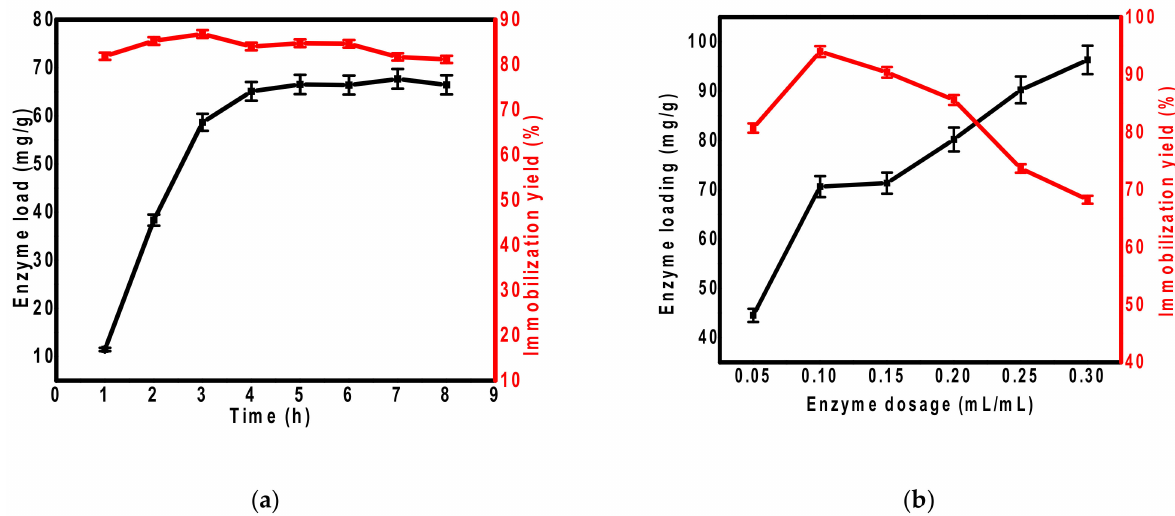
Figure 2. The effect of the ( a ) immobilization time and ( b ) enzyme dosage on enzyme loading and immobilization